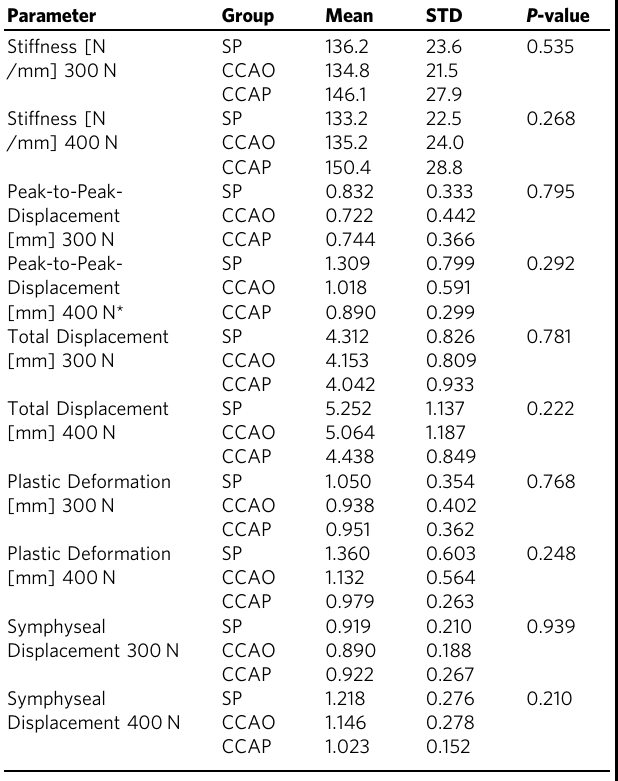
Table 3 Statistical analysis of the synthetic bone models tested by